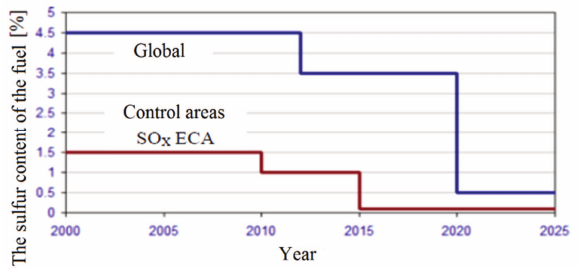
Fig. 2. Permissible sulfur content in fuel according to Annex VI MARPOL [3]